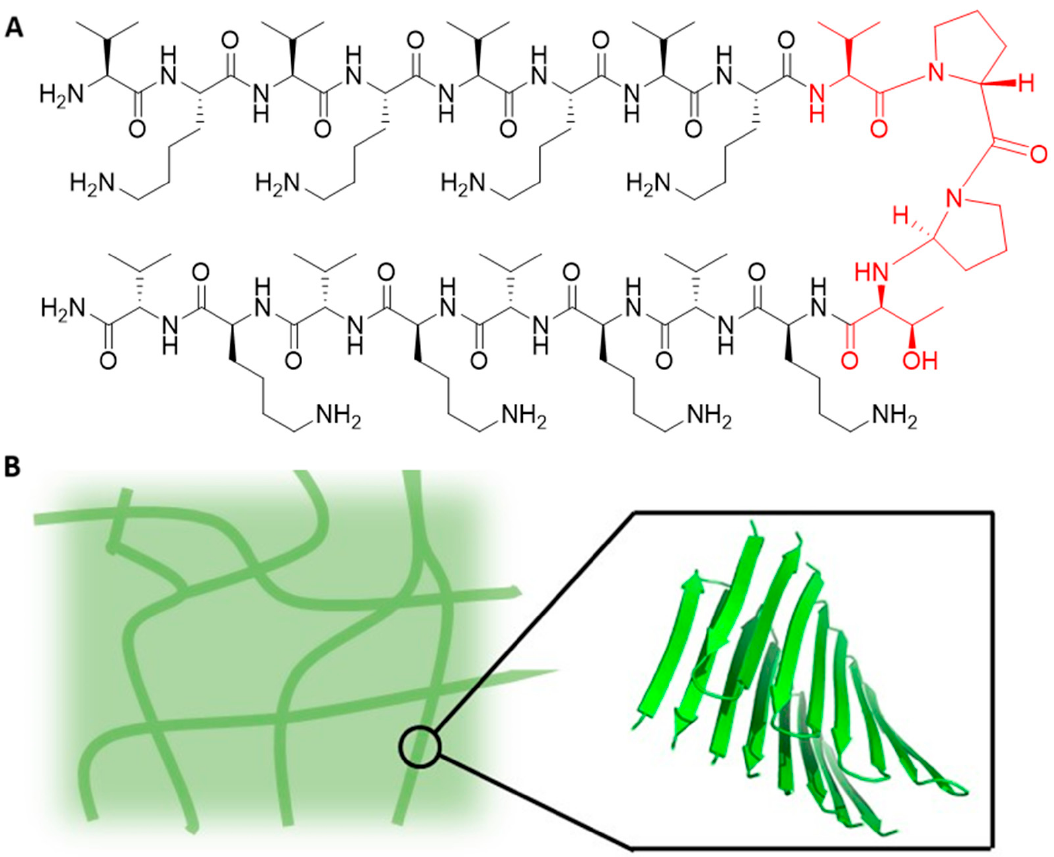
Figure 6. Structure of the MAX1 peptide, composed of alternating valine and lysine residues ( A ) and ribbon representation of the fibrils ( B ).